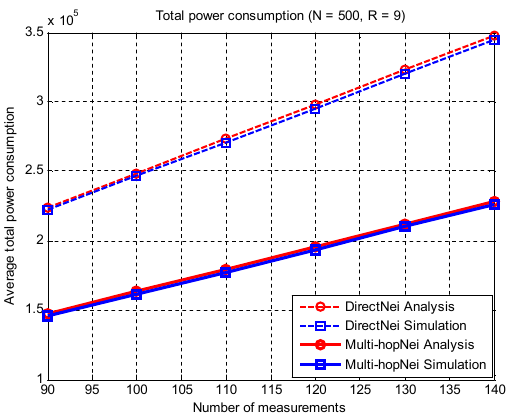
Figure 15. Total power consumption with different number of measurements sending to the base-station (BS) in both methods are compared; The BS is at the center of the sensing area; N = 500 sensors; transmission range R =